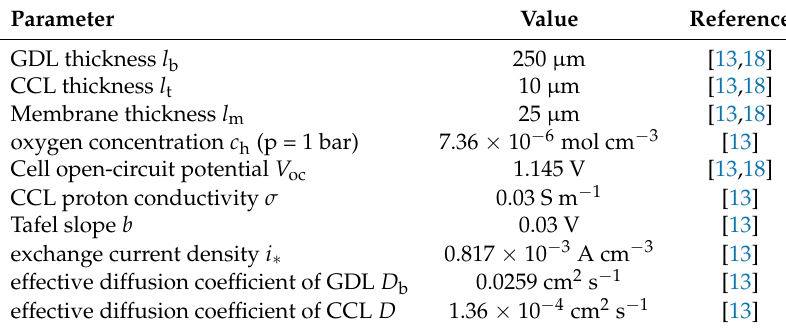
Table 1. Model parameters